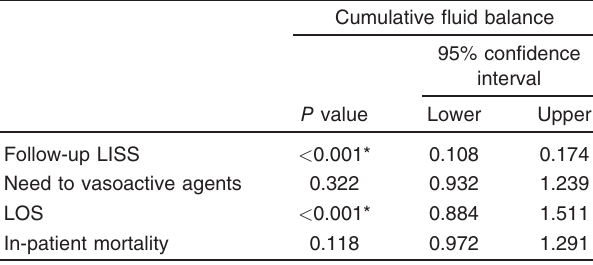
Table 5 Cumulative fluid balance as a predictor of